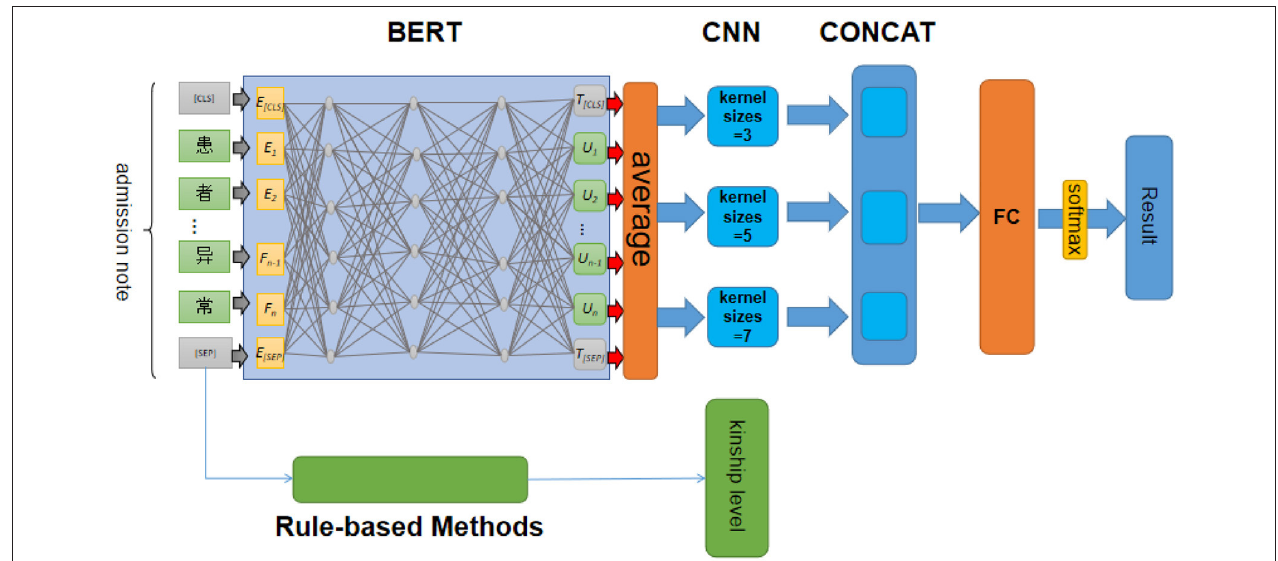
FIGURE 2 | Architecture of the BERT–CNN